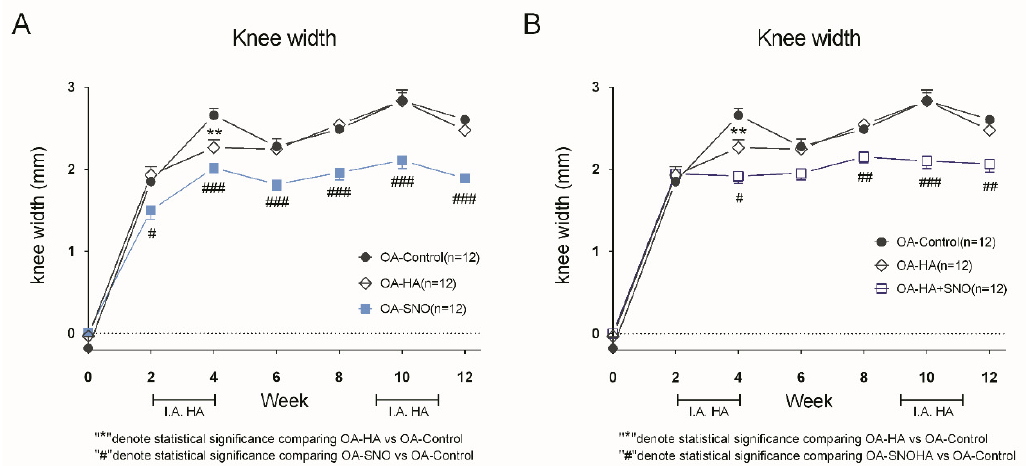
Figure 2. Joint swelling measurement of the OA rats. ACLT + MMx was performed to induce knee OA at week 0, and di ff erent treatments were given according to the experimental design. ( A ) Biweekly knee width measurements of the OA-control, OA-HA (hyaluronic acid), and OA-SNO (shea nut oil) rats. ( B ) Biweekly knee width measurements of the OA-control, OA-HA and OA-SNOHA (hyaluronic acid + shea nut oil) rats. The data are presented as the ∆ knee width (mm), and the values are expressed as the mean ± SEM. Two-way ANOVA and Sidaks’s multiple comparisons test were used to analyze the data. # p < 0.05, ## / ** p < 0.01, ### p < 0.001.